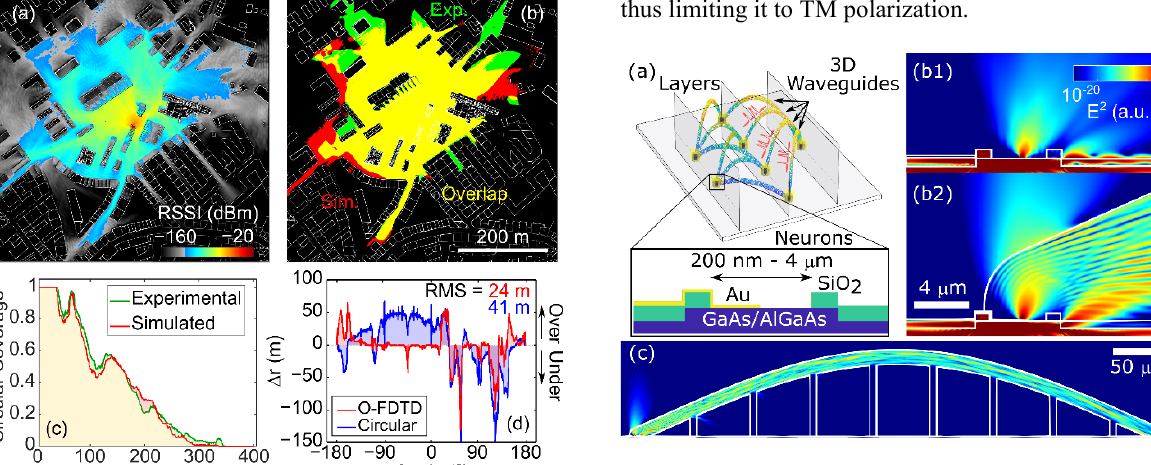
Fig. 4 . 3D waveguides for photonic neuromorphic computing. (a) 3D-interconnected planar neural network concept. (b) Light outcoupling from GaAs/AlGaAs micro-LED at  = 850 nm. (c) Light propagation in a supported